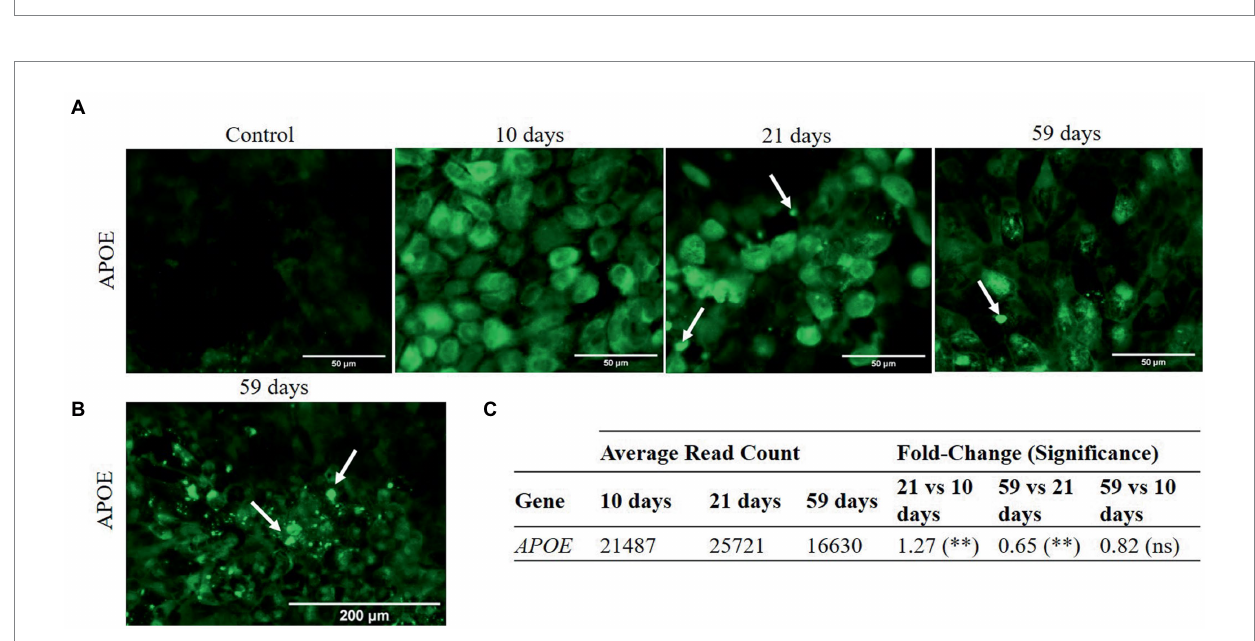
FIGURE 4 Immunocytochemistry images and gene expression of APOE in cell cultures at 10, 21 and 59 days. Differential gene expression analysis was carried out following the DESeq2 method (ns: q -value >0.05; *: q -value <0.05; **: q -value <0.01). (A) APOE is detected in the cytoplasm of RPE cells at 10, 21, and 59 days in culture. Extracellular signals (arrows), possibly linked to deposit formation, were detected after 21 and 59 days in culture (scale bar 50 μ m). (B) Profusion of extracellular APOE punctate deposition at 59 days (scale bar 200 μ m). (C) APOE expression increases from 10 to 21 days in culture and decreases afterwards, from 21 to 59 days in